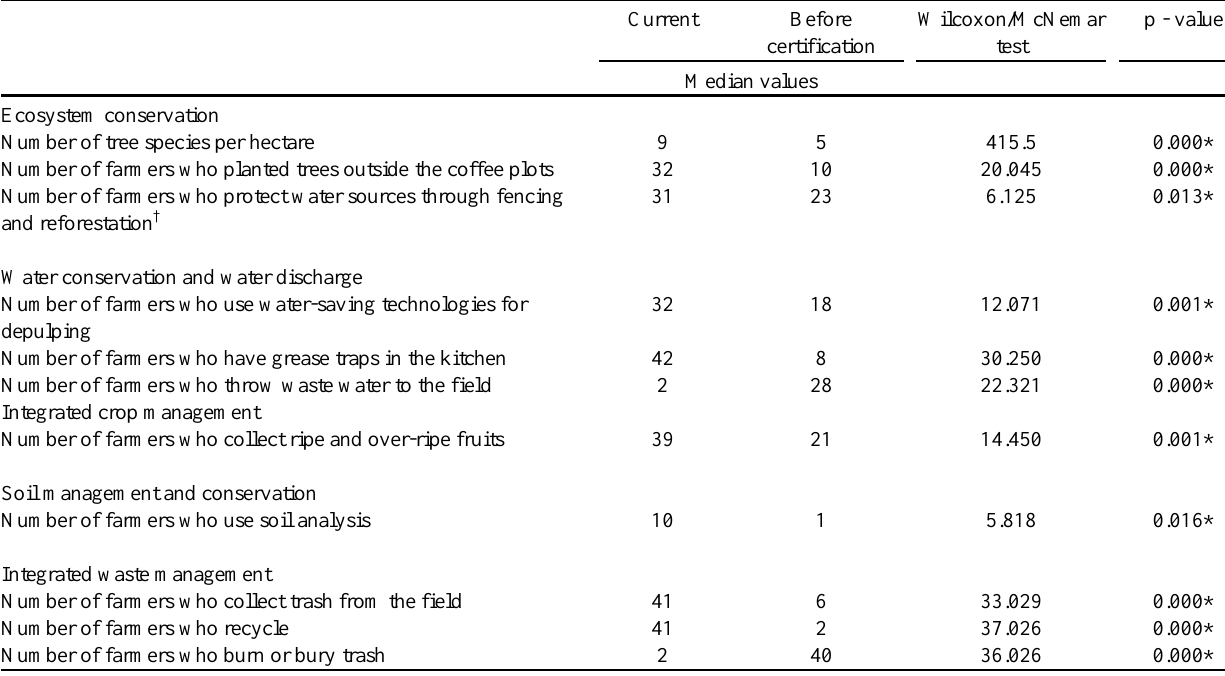
Table 4 . Difference in practices for certified farms before and after joining certification (n = 43)